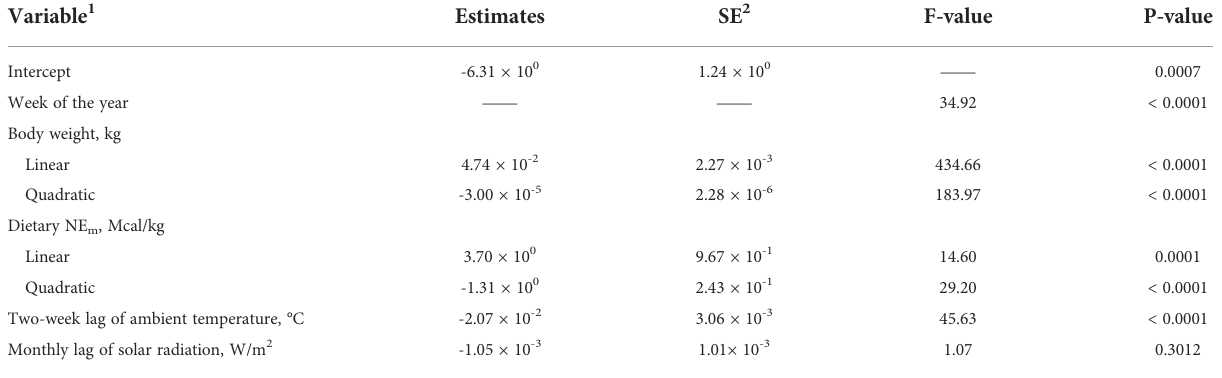
TABLE 7 Base model with two-week lag of ambient temperature and monthly lag of solar radiation.